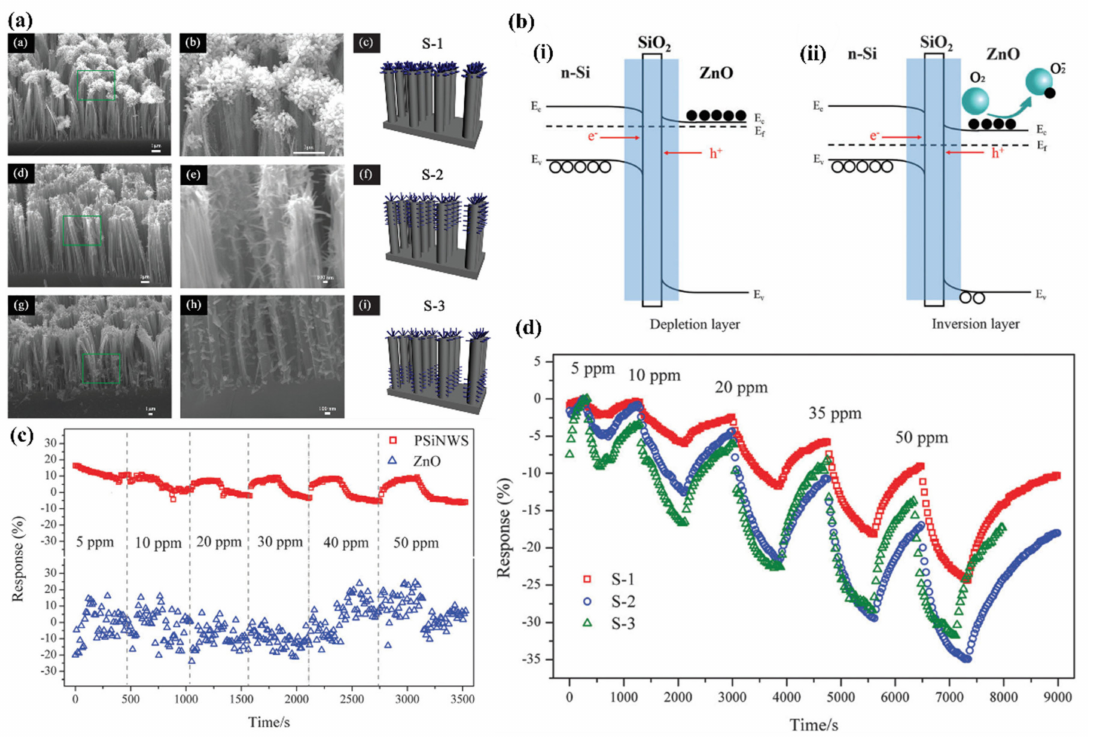
Figure 18. ( a ) SEM images of ZnONWs / PSiNWs hybrid strictures and schemes of these structures with di ff erent ZnO coverage; ( b ) scheme of proposed sensing mechanism-energetic bands of ZnONWs / PSiNWs ( i ) before and ( ii ) after exposure to oxidizing gas; ( c ) response of the of bare PSiNWs and ZnO to NO 2 at RT; ( d ) responses of ZnONWs / PSiNWs hybrids presented in SEM images. Reproduced from [157], with permission from Royal Society of Chemistry,